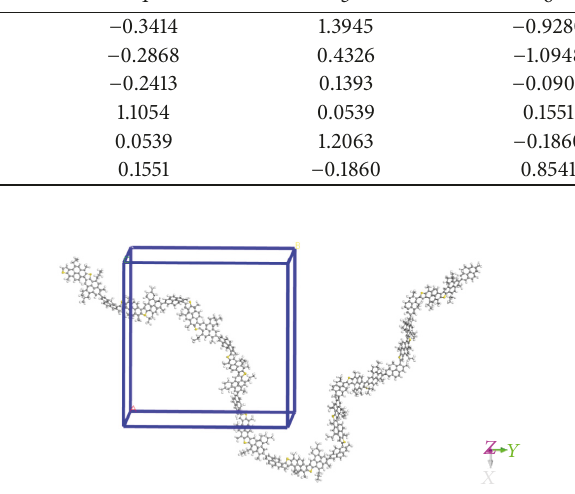
Figure 13: Initial model of asphaltene at the density of